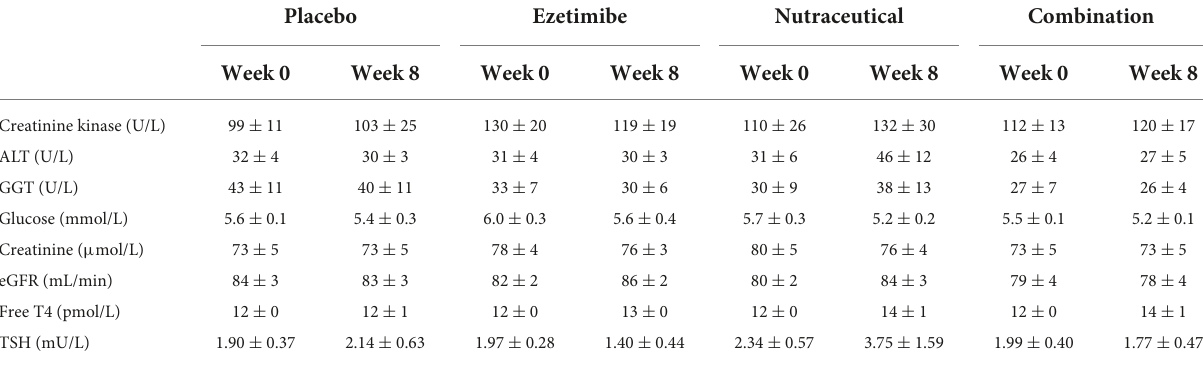
TABLE 3 Effect of the interventions on laboratory blood safety parameters including creatinine kinase, liver function, renal function, fasting glucose, and thyroid function over the 8-week treatment